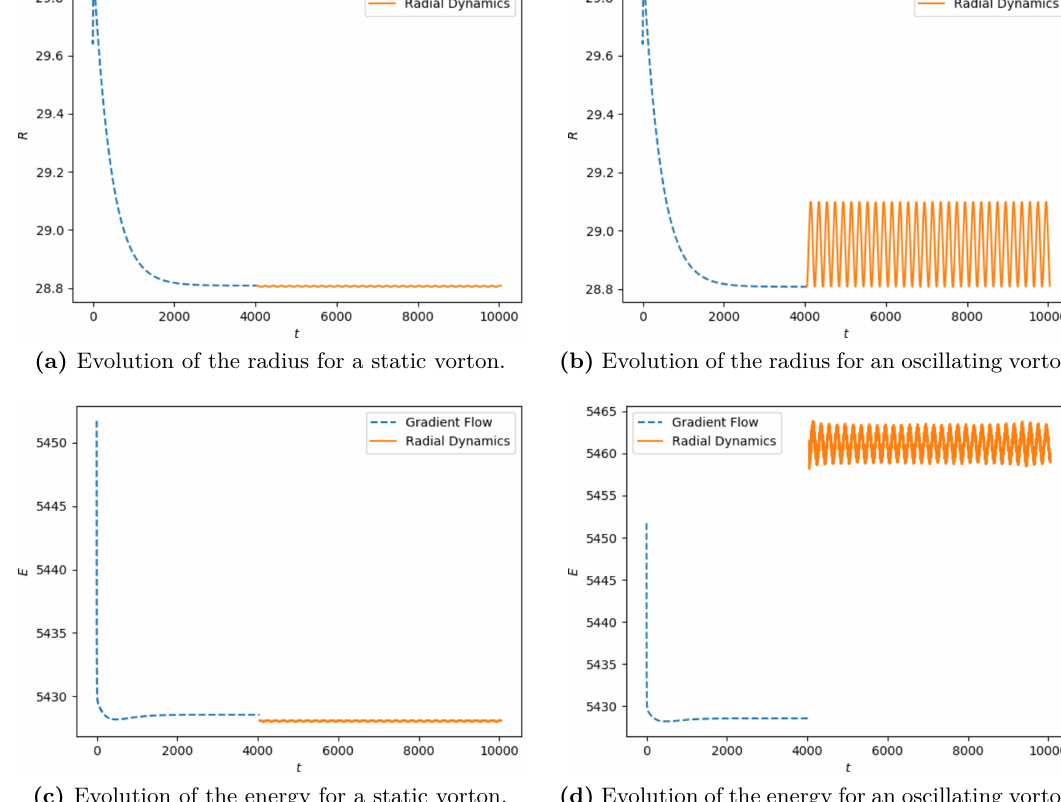
Figure 17 . The evolution of the radius is shown in figures 17a and 17b while the evolution of the energy is shown in figures 17c and 17d during both the gradient flow process and full radial dynamics simulations. This vorton is the one displayed in figure 9a (parameter set A). The static vorton oscillates slightly around its equilibrium radius, while the perturbed vorton oscillates more dramatically around a larger equilibrium radius. There is a very small reduction in the energy of the static vorton due to the numerical approximations. The perturbed vorton has a significantly increased energy and it slightly oscillates although at far less than the percent